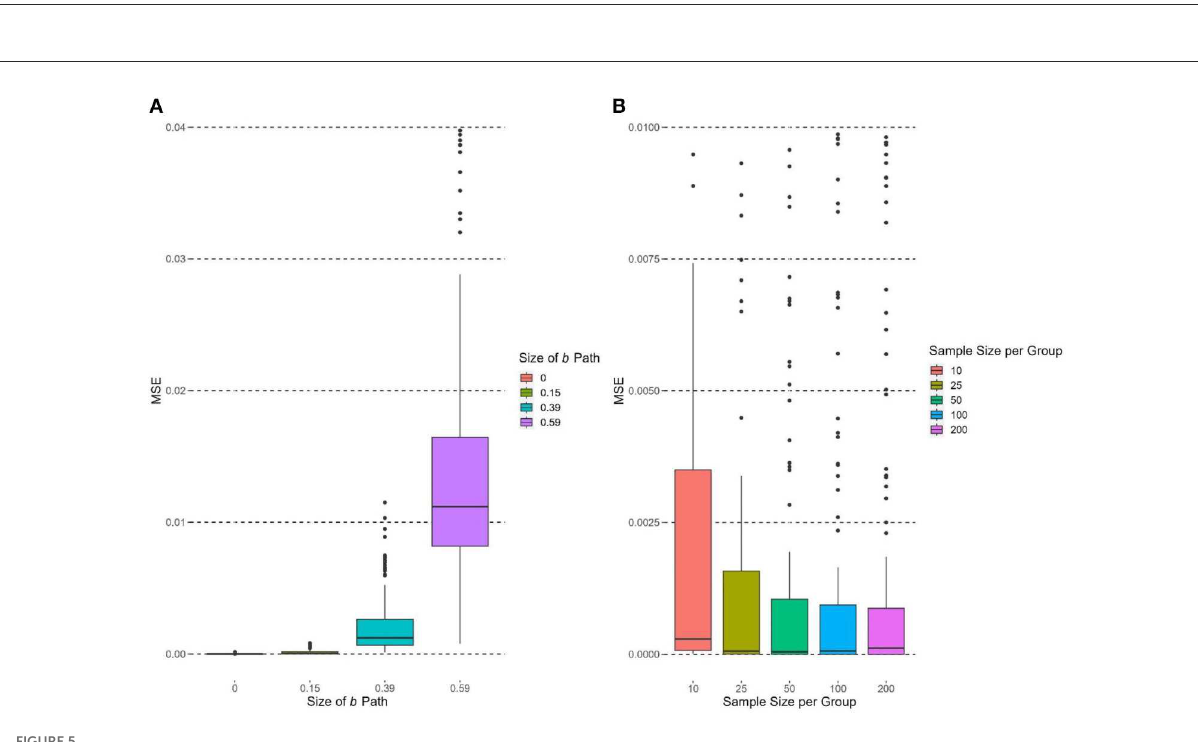
FIGURE5 Boxplots of MSE of ˜ υ OPE grouped by experimental conditions. Due to limit of y-axis, 0.97% and 15.83% of the observations are not shown in (A) and (B) ,